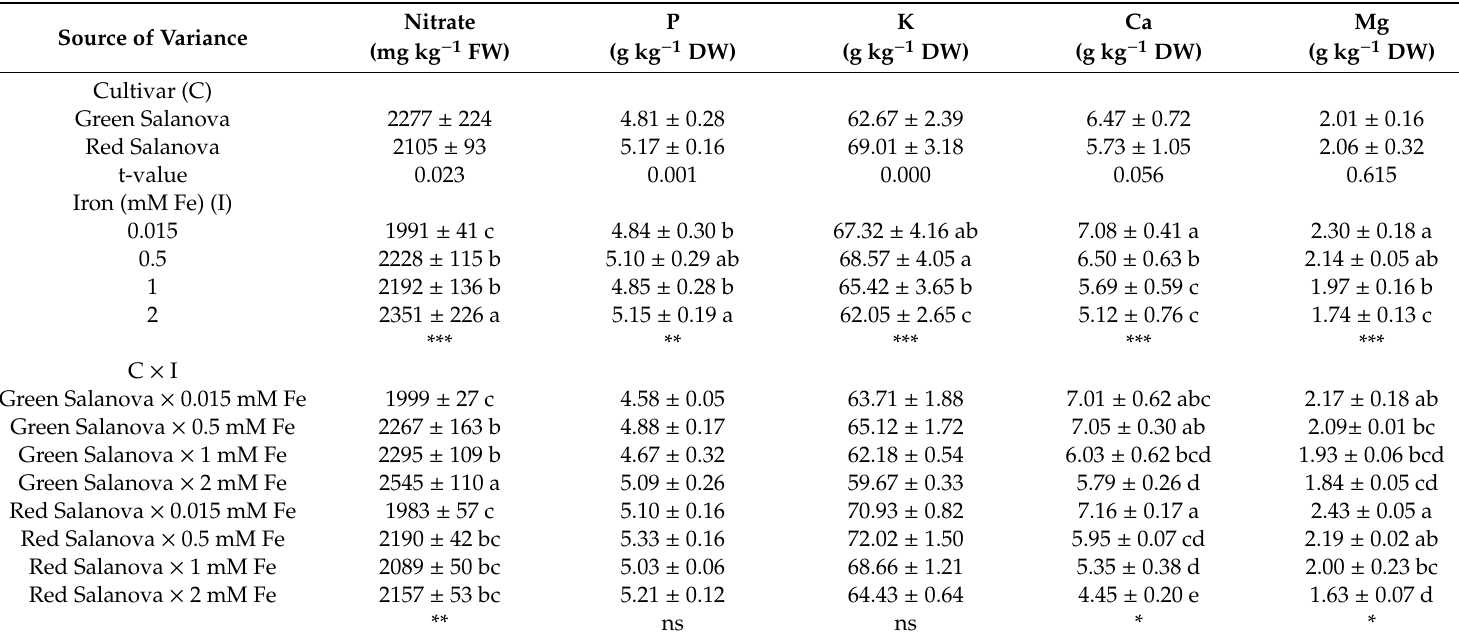
Table 2. Analysis of variance and mean comparisons leaf mineral composition in green and red Salanova butterhead lettuce grown under increasing Fe concentration in the nutrient